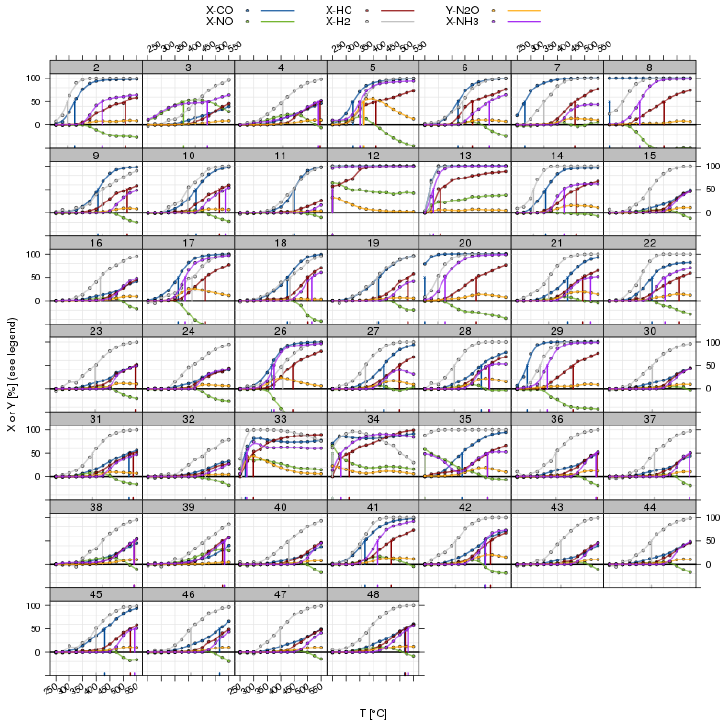
Figure 7. Light-off curves for all pollutants in a three-way catalyst (TWC) experiment with λ perturbation; overview for all catalyst positions in a screening plate (commercial benchmarks have been omitted). The vertical lines indicate the position of T 50 from the automated fitting procedure.